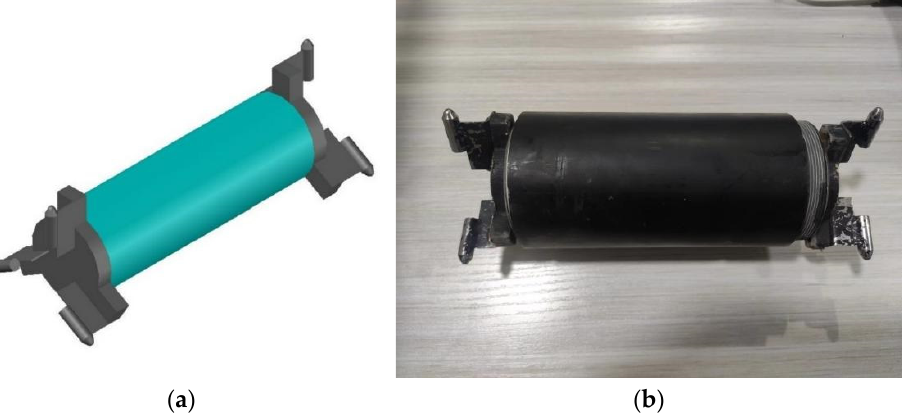
Figure 2. Structure schematic of the capsule. ( a ) Capsule geometry model; ( b ) Capsule physical model .